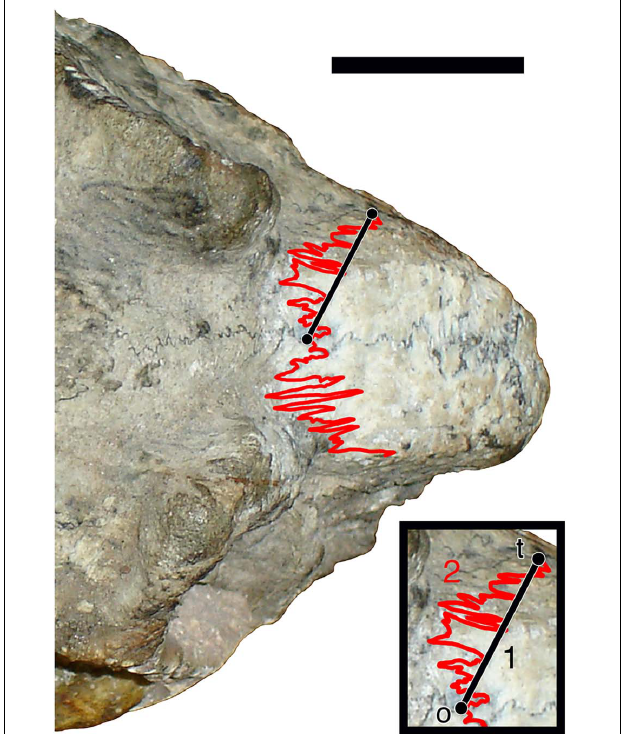
FIGURE 1 | Illustration of the measurement protocol used in calculating the sutural complexity index. Straight black line (1) indicates least path length from the origin (o) to the terminus (t) of the left naso-frontal suture in dorsal view. Red line (2) shows total path length of the suture between these points. Sutural complexity index represents 1 ÷ 2. Scale bar represents 1